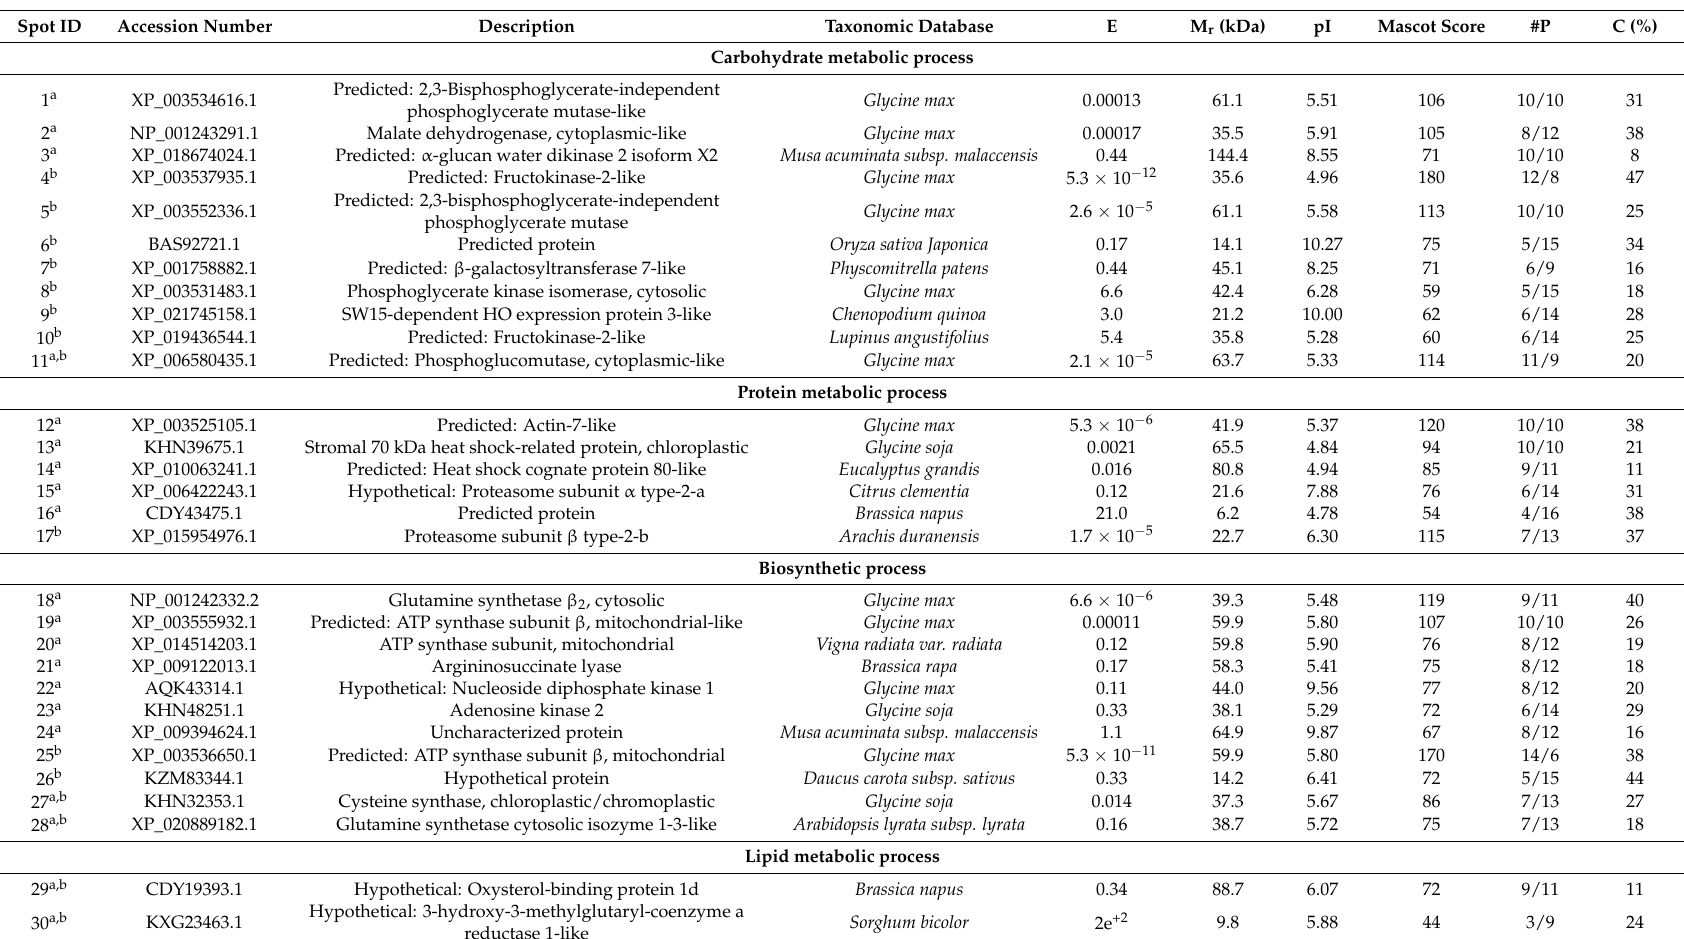
Table 1. Root proteins increased by more than two-fold at low (4 µ M) phosphorus (P) in contrasting soybean